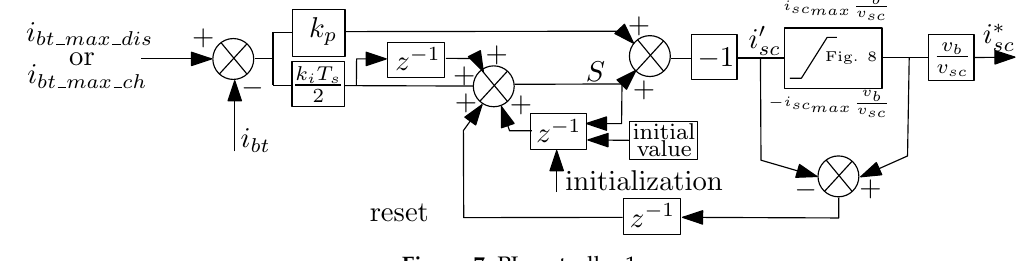
Figure 7. PI controller